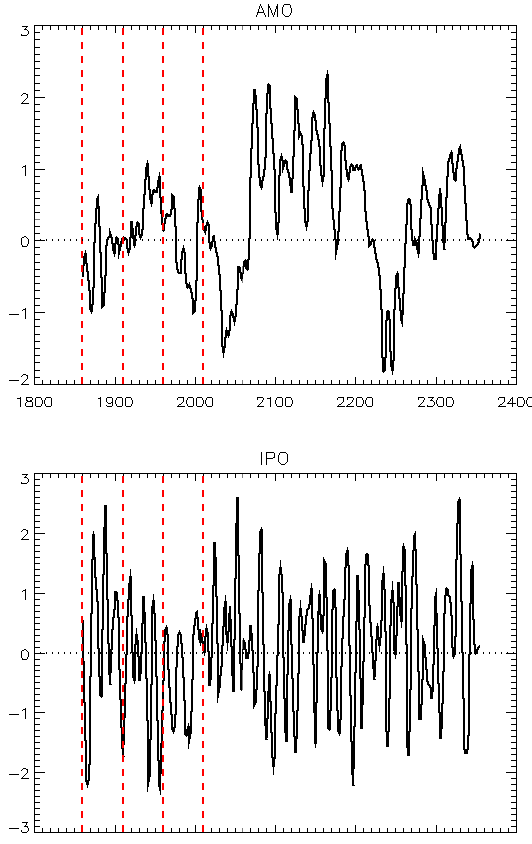
Fig. 20. Evolution of the AMO and IPO indices in the HadGEM2- ES pre-industrial control simulation. Vertical red lines show 50-yr intervals chosen as interval between ensemble member initial con- ditions. 4 ensemble members have been performed to